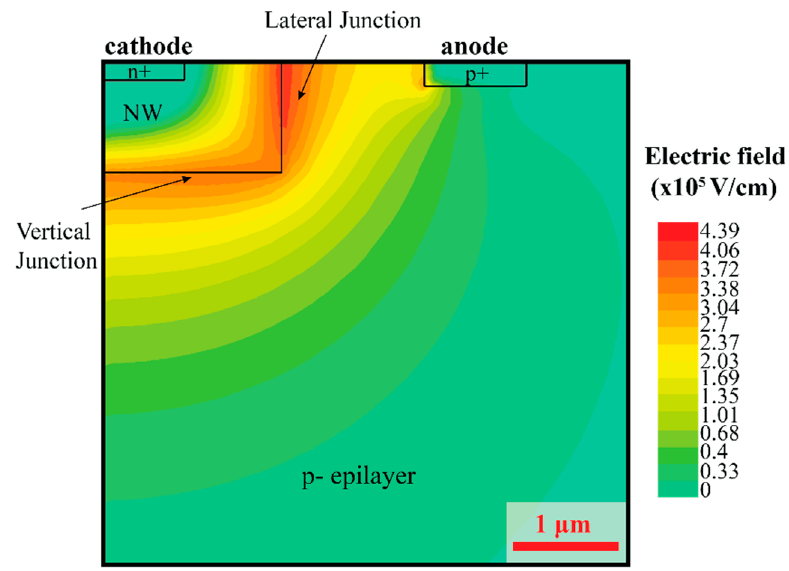
Figure 3. Simulated electric field profile at the cathode-anode junction at the central multiplication area of the CASPAD at an excess bias voltage (V ex ) of 2 V.